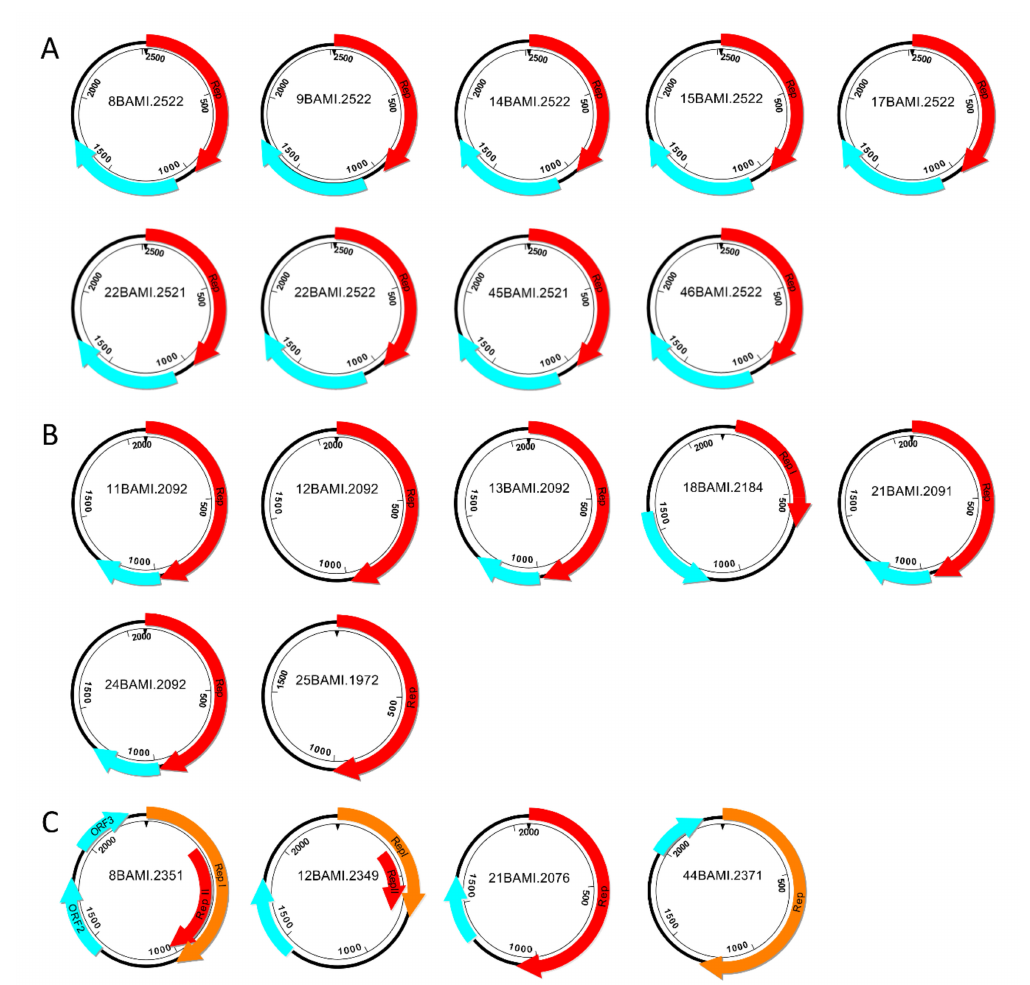
Figure 3. Schematic illustration of BMMF-like DNA elements recovered from buffalo milk. Red arrows indicate rep genes starting with ATG; orange arrows show rep genes starting with TTG. The light blue arrows represent further potential ORFs. According to the results of the in silico analysis, circular DNA elements were assigned to three groups ( A – C ). Group ( A ) contains nine related isolates, which could be assigned to the GenBank entries CMI1.252 and HCBI6.252; group ( B ) comprises seven elements, which exhibit the greatest homologies to other BMMF1 isolates; group ( C ) includes four circular DNAs belonging to the BMMF2